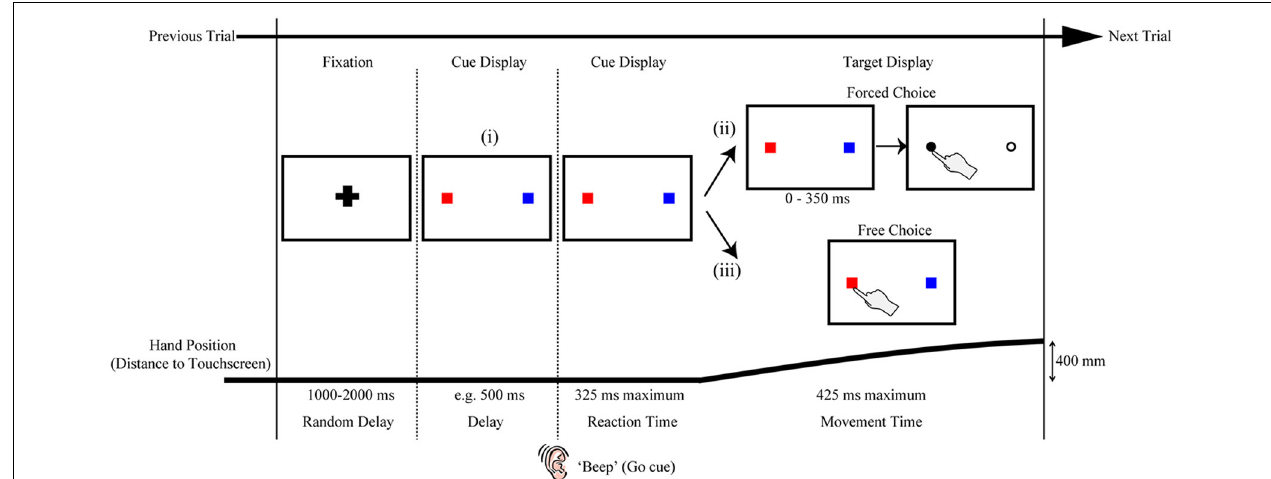
FIGURE 2 | Variations on the rapid reach task. The sequences of events are structured similarly to that shown in Figure 1A . Note that the red and blue squares in the target displays are only used here as placeholders; in principle, a wide variety of stimuli (e.g., numerals, shapes, pictures, etc.) can be positioned at these placeholder locations and the resulting reach trajectories toward these stimuli can be used as an index of the level of competition between those stimuli. The variations on the task noted in (i, ii, or iii) are meant to be mutually exclusive for a given trial. (i) One variation on the task can be to include a delay interval between the Fixation and Reaction Time epochs of the trial. In effect, the inclusion of the delay interval will allow participants additional time (in the example here, 500ms) to view the stimuli before being required to immediately act toward those stimuli. This can be beneficial, for example, when the processing of the stimuli requires additional cognitive resources and/or remembered associations, or when determining the timeline over which a